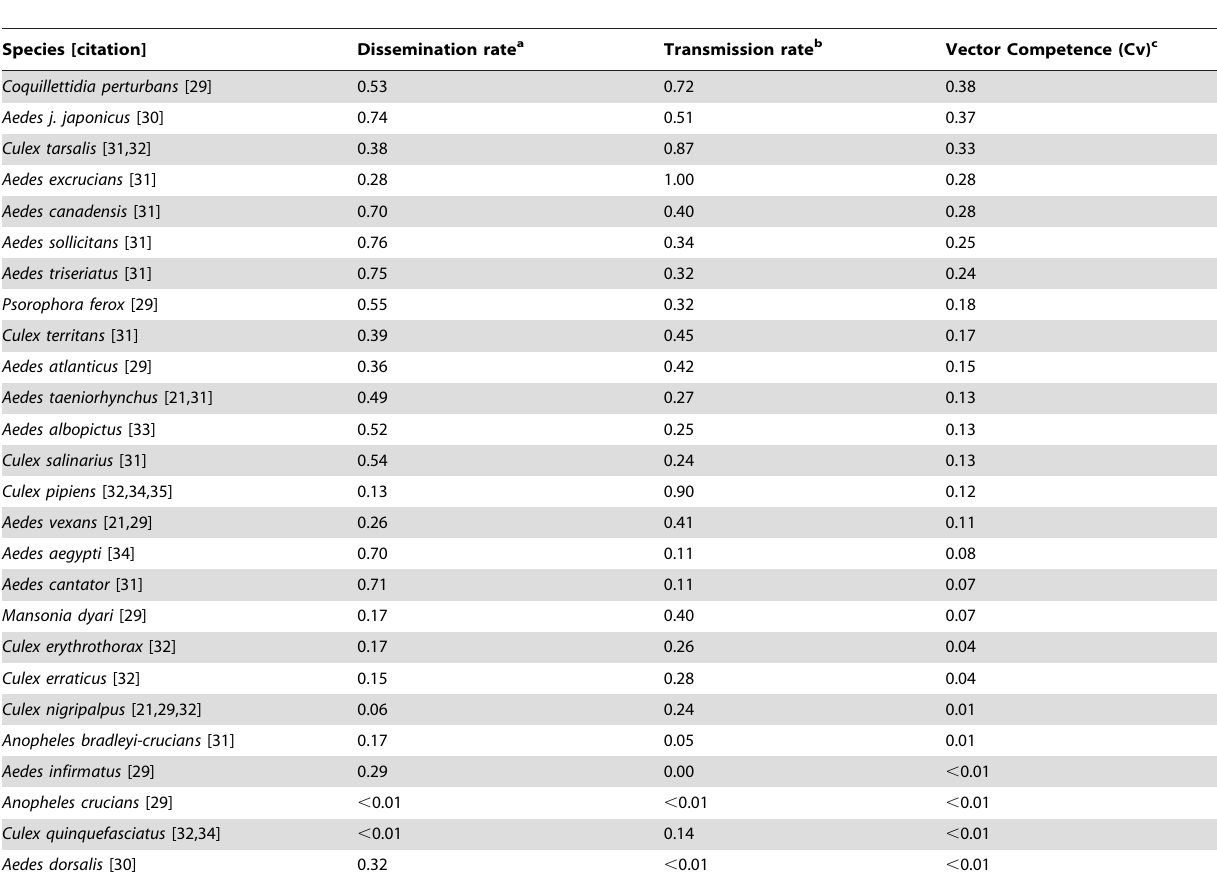
Table 1. Estimated dissemination rate, transmission rate, and vector competence for mosquitoes exposed to 7.5 log PFU/ml Rift Valley fever